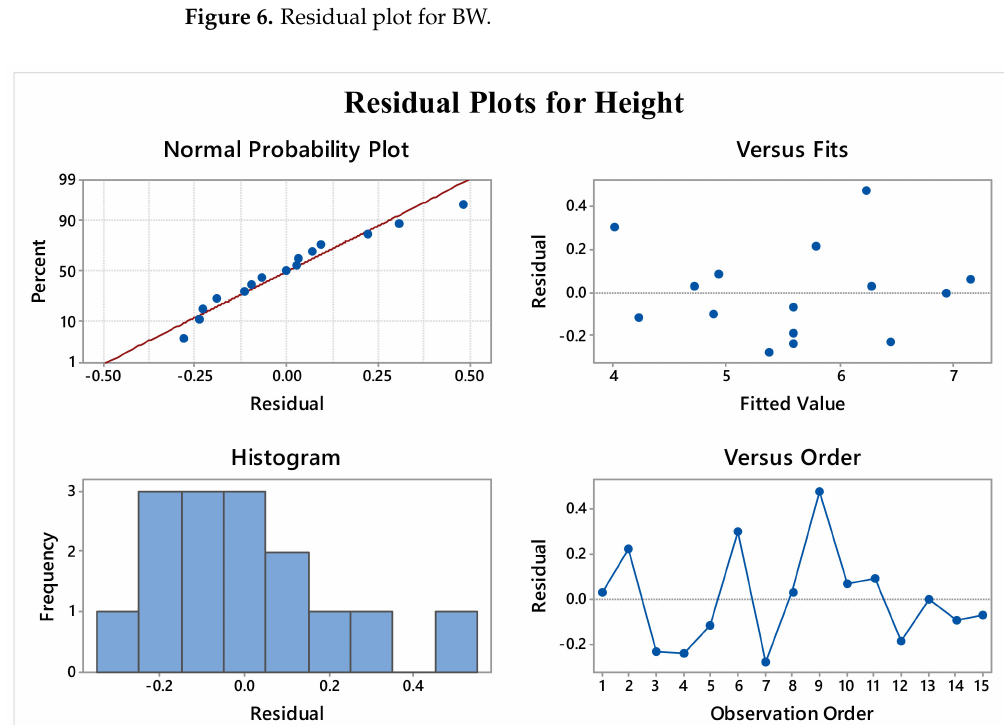
Figure 6. Residual plot for BW.